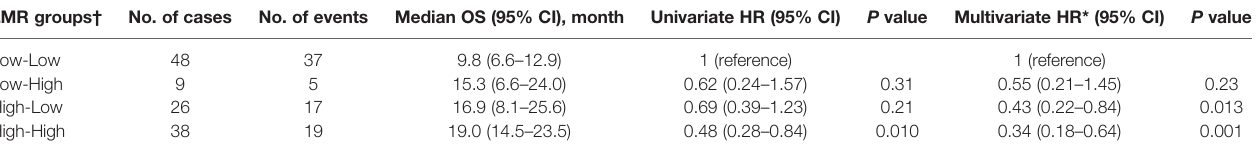
TABLE 4 | Association of changes in LMR with OS in multivariable Cox regression models of advanced gastric cancer patients.